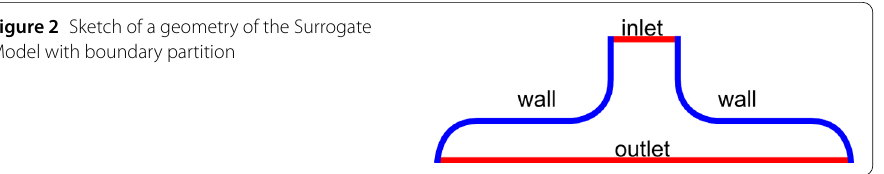
Figure 2 Sketch of a geometry of the Surrogate Model with boundary